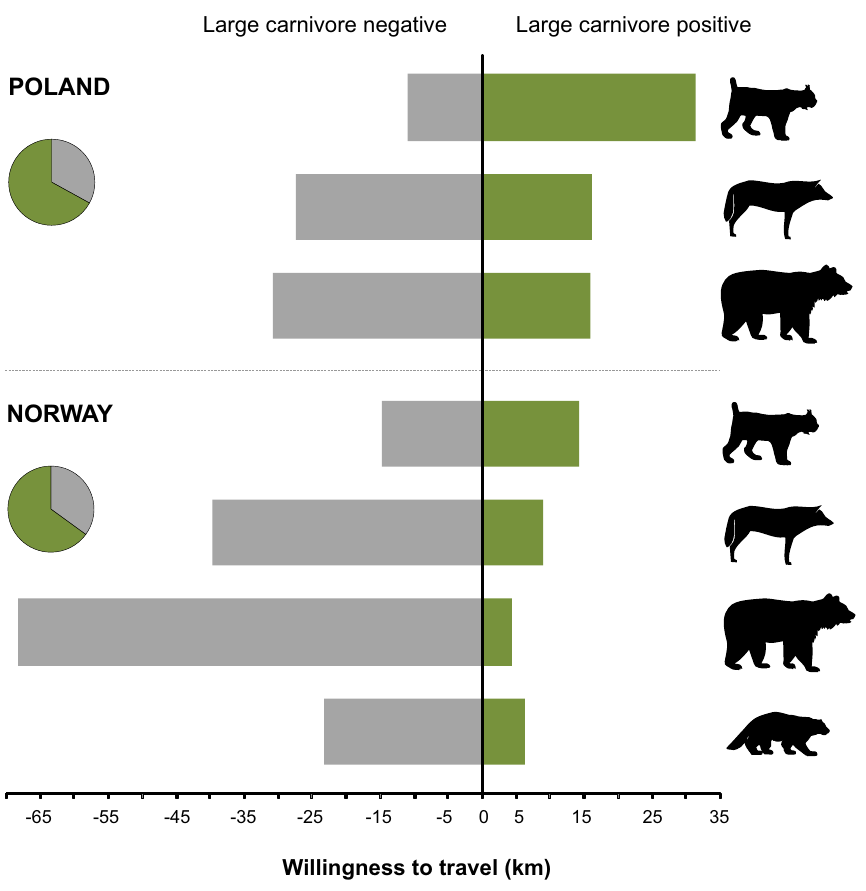
Figure 3. Estimates for the willingness-to-travel (kms) shown by respondents belonging to the large carnivore positive (green) and large carnivore negative (grey) classes in Poland and Norway according to the Latent Class Multinomial Logit model. Pie charts indicate the share of the two classes of respondents for each